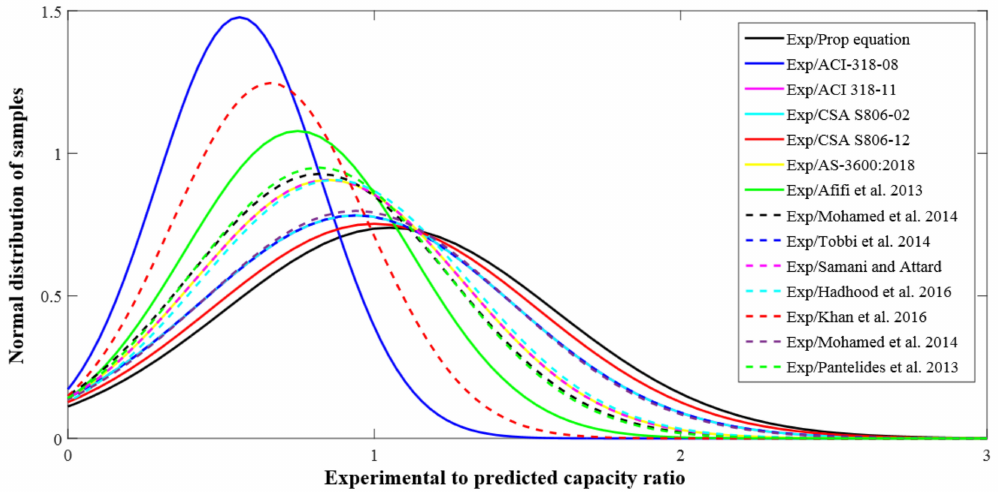
Figure 12. Normal distribution of experimental to predicted strength of GFRP-RC compressive